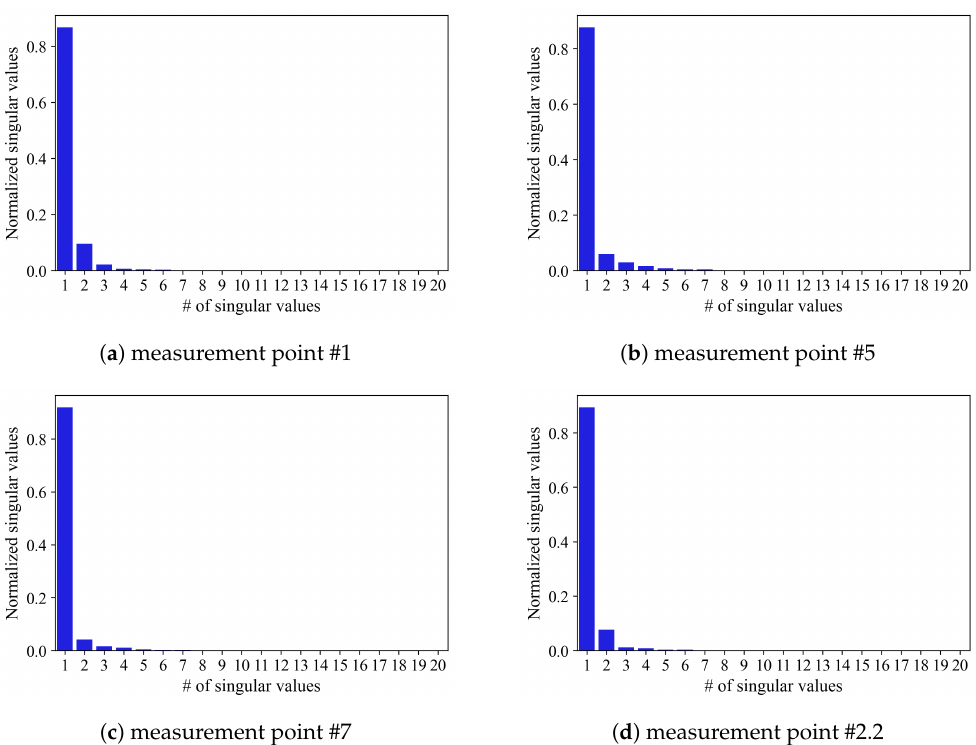
Figure 3. Normalized singular values of the thermal field for 4 snapshot